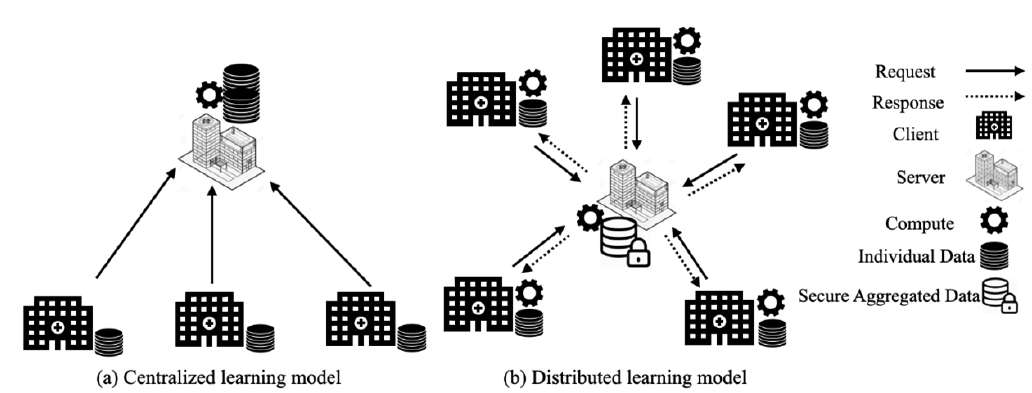
Figure 1. Centralized vs distributed data model applied to AFND (partially based on [8]).This figure shows two different models of operation of the AFND.net site calculations. Model (a) shows the current centralized calculation model, where the server collects all data from participating sites in the calculation and performs collaborative calculations on the server in a centralized manner. Model (b) presents our new distributed model proposed for AFND.net which allows each site participating in the collaborative analysis to perform the calculations locally without moving its data to the server. After that, they send calculation results that allow the server to just safely perform aggregate calculations and generate the